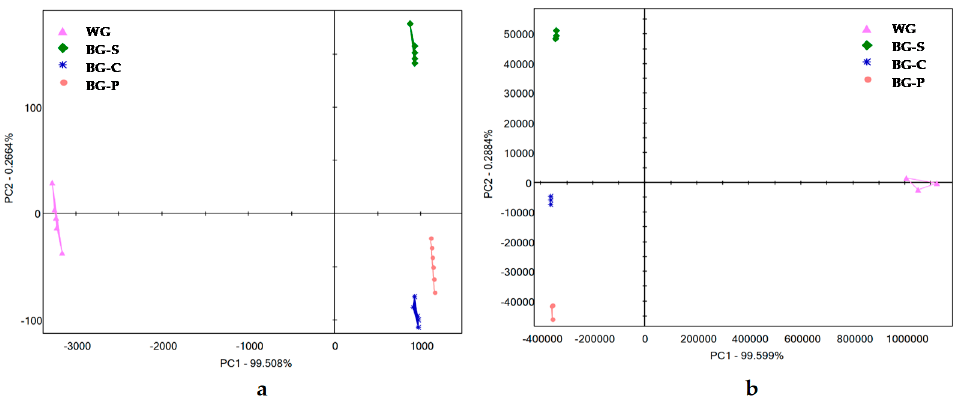
Figure 6. PCA plot of the similarities and differences in the taste and profile of volatile compounds identified in the garlic samples: ( a ) e-tongue, ( b ) e-nose. WG—white garlic, BG-C—black garlic cloves, BG-P—black garlic powder, BG-S—black garlic spread.